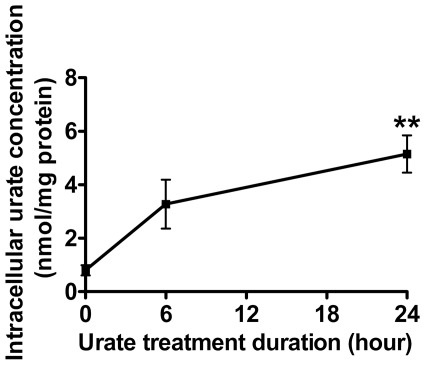
Urate accumulation in cortical neurons.
A) Time-dependent effect of 100 µM exogenous urate on its intracellular content in primary cortical neurons. One-way ANOVA followed by Newman-Keuls test: **P<0.01.